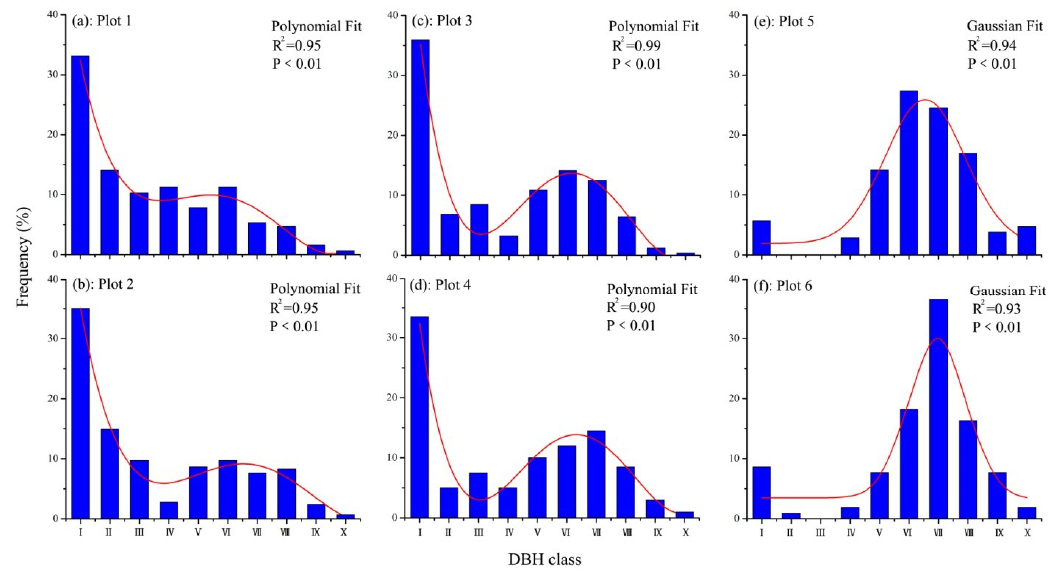
Figure 3. DHB class structure of U. pumila trees under different grazing pressures.